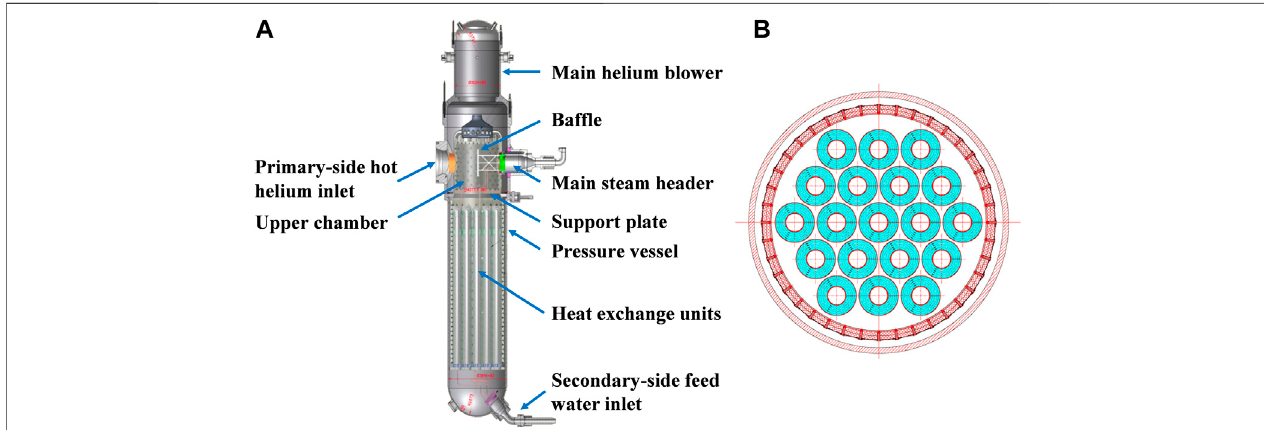
FIGURE 1 | Schematic of the HTGR OTSG Zhang et al., 2009. (A) Geometrical model. (B) Cross section.